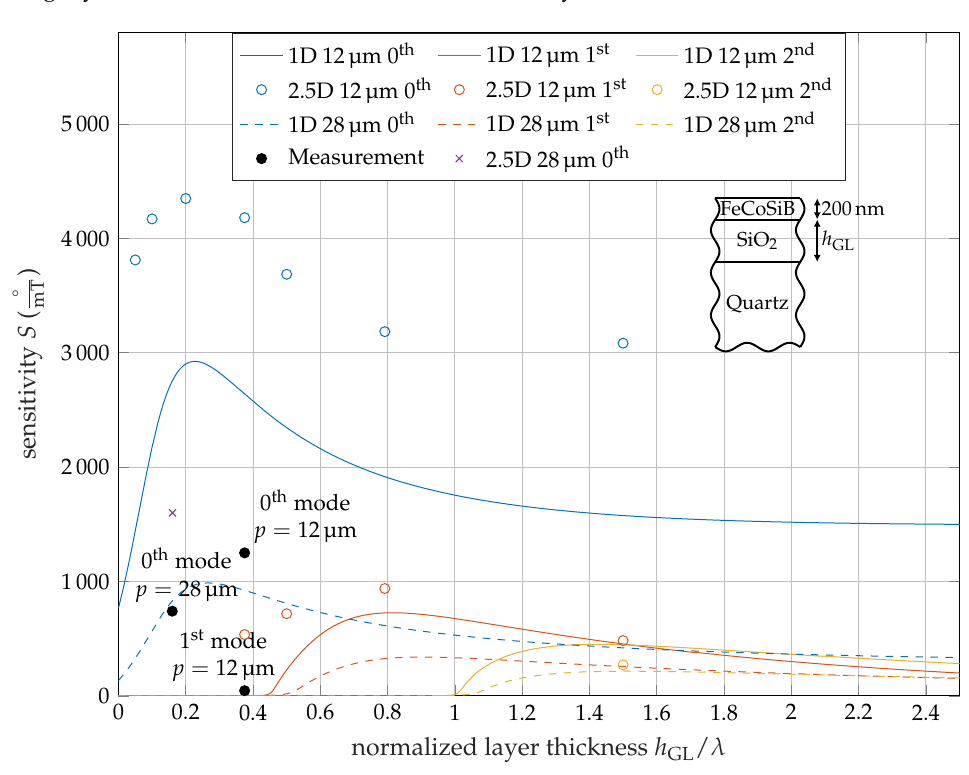
Figure 5. Comparison of sensitivity results for isotropic (1D) and anisotropic (2.5D) calculation for p = 12µm and p = 28µm for the fundamental, first- and second-order modes. Due to the fixed MS layer thickness, the normalized data are not entirely wavelength independent. For comparison, the measurement results are